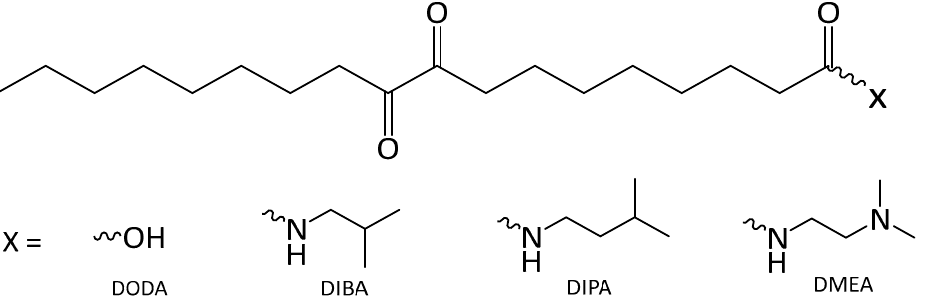
Figure 1. Structures of the alkyl amide derivatives of 9,10-dioxooctadecanoic acid (DODA) examined: N-isobutyl-9,10-dioxooctadecanamide (DIBA), isopentyl-9,10-dioxooctadecanamide (DIPA) and N-(2- (dimethylamino)ethyl)-9,10-dioxooctadecanamide